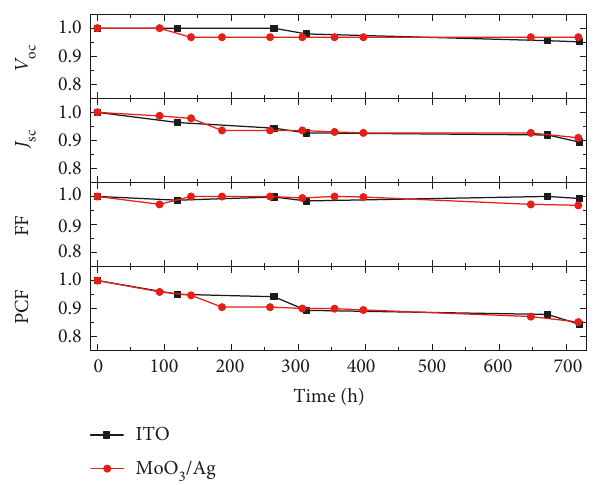
Figure 5: Variation of the normalized photovoltaic performance parameters with the time for ITO-free OSCs and ITO-based reference OSCs,